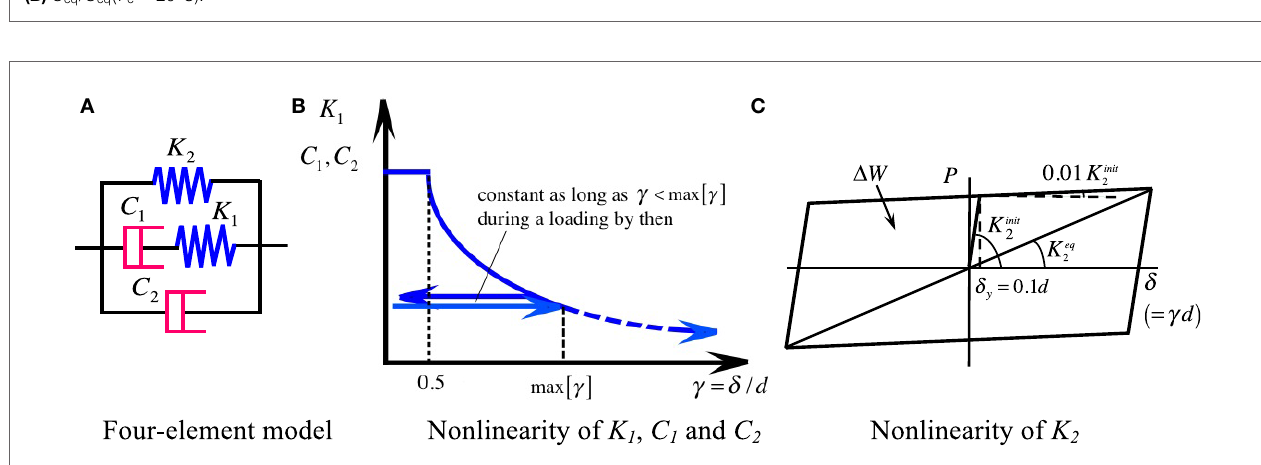
FIGURE 8 | NLF model . (A) Four-element model; (B) non-linearity of K 1 , C 1 , and C 2 ; (C) non-linearity of K